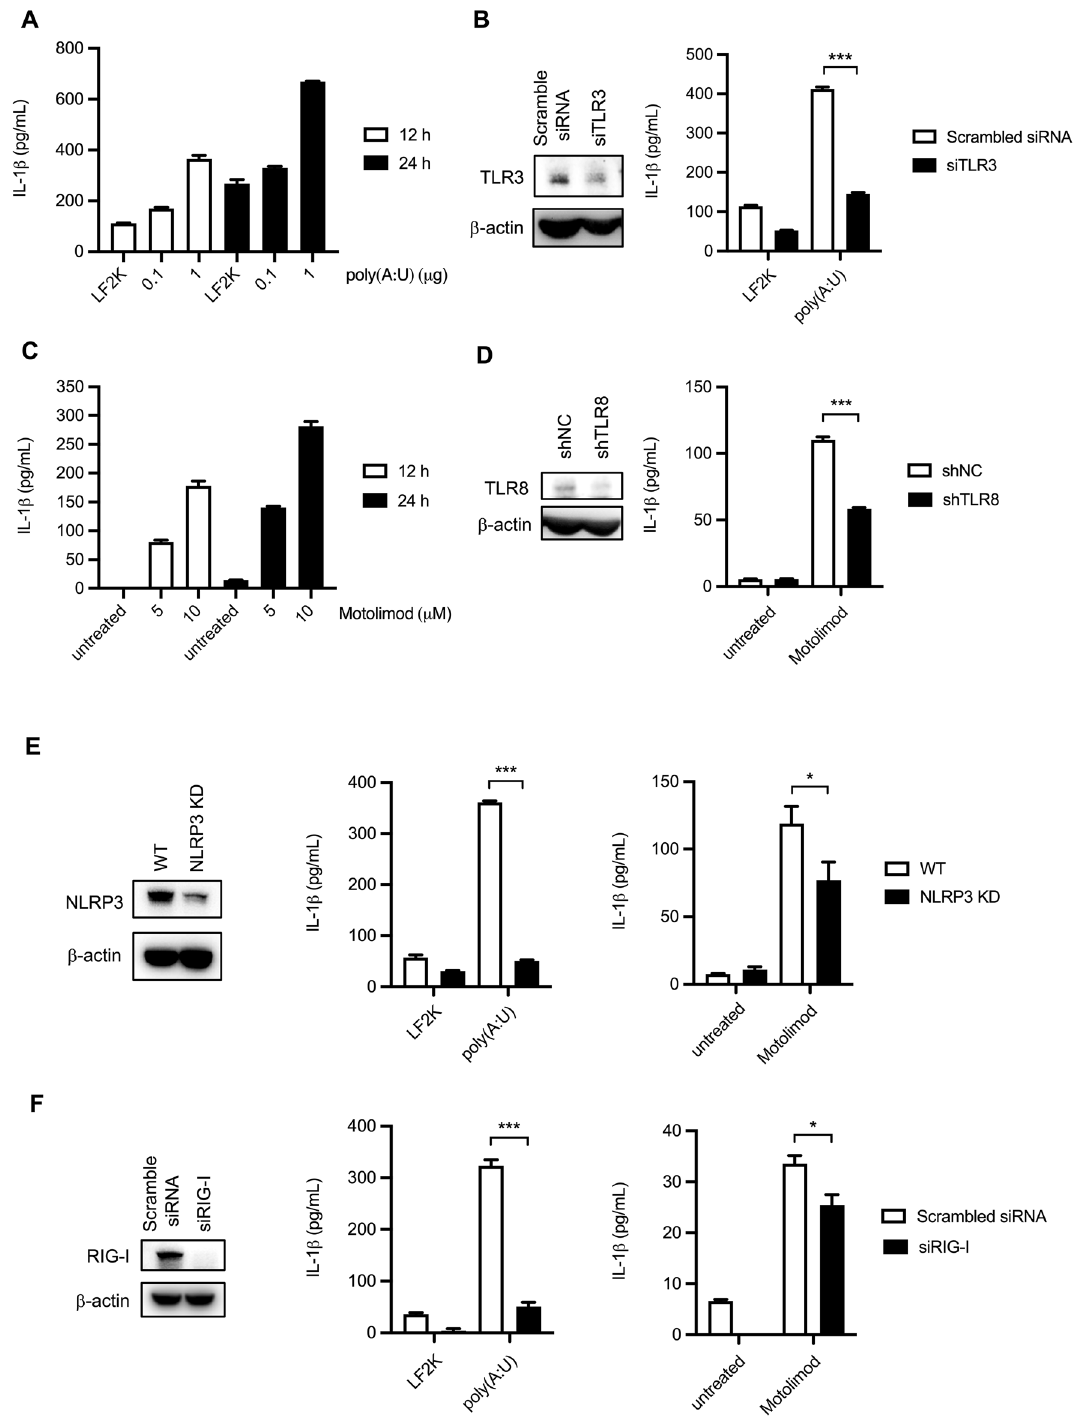
Figure 6. NLRP3 and RIG-I are implicated in TLR3 and TLR8 induced IL-1β release in THP-1 macrophages. ( A ) THP-1 macrophages were stimulated by poly(A:U) (0.1, 1 µg) for 12 and 24 h. The IL-1β protein levels were detected by ELISA. ( B ) PMA- primed THP-1 were transfected with TLR3 siRNA and scrambled siRNA for 48 h, and then stimulated by 1 µg poly(A:U) for 12 h. The knockdown efficiency was confirmed by Western blot. The expression levels of IL-1β in the supernatant were analyzed by ELISA. ( C ) PMA-primed THP-1 cells were treated with TLR8 agonists motolimod (5, 10 µM) for 12 and 24 h. The supernatant was collected and the expression of IL-1β was examined by ELISA. ( D ) The shTLR8 transduced THP-1 macrophages were treated with motolimod for 12 h. TLR8 and β-actin in the cell lysates were detected by Immunoblot. IL-1β levels were quantified by ELISA. ( E ) The NLRP3 KD THP-1 macrophage was transfected with poly(A:U), or treated with motolimod for 12 h. The IL-1β levels in the supernatants were examined by ELISA. ( F ) PMA-primed THP-1 was transfected with siRIG-I and scrambled siRNA for 48 h. Then the transfected cells were stimulated by poly(A:U) or motolimod for 12 h. The expression of RIG-I and β-actin was determined by Western blot. The ± secretion of IL-1β was measured by ELISA. Data are expressed as mean value SD (* p < 0.05, *** p < 0.001, Student’s unpaired